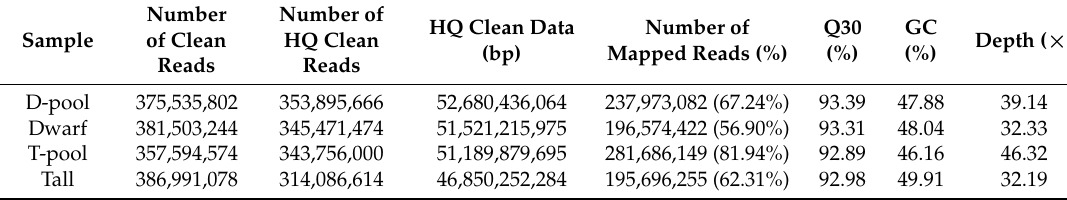
Table 3. Summary of the sequencing data for each sample. Table 4. Numbers of single ‐ nucleotide polymorphisms (SNPs) and insertions/deletions (InDels) for each sample.